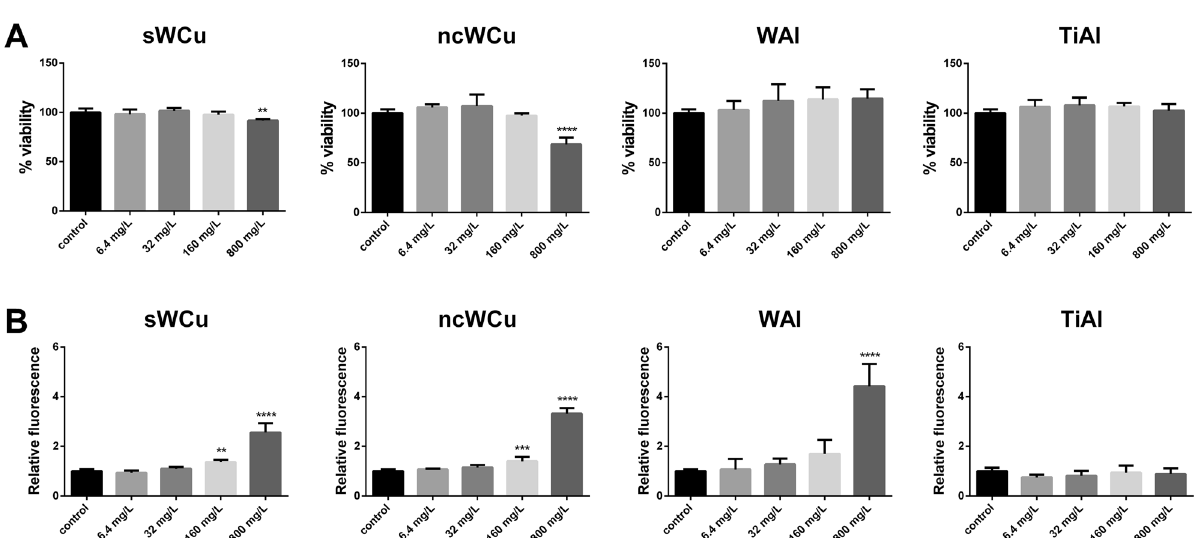
Figure 3. Effects in A549 cells after being exposed to different concentrations of the powder leachates. ( A ) Viability of A549 cells (Neutral Red assay). Results are expressed as % of control (untreated cells). ( B ) Oxidative stress (ROS levels) in A549 cells. Results are expressed as the relative fluorescence value to the control (untreated cells) which was assigned a value of 1. Data represent the mean ± standard deviation, SD. Differences were established using a One-way ANOVA followed by Dunnett post hoc test to compare every mean with the control, and considered significant at P ≤ 0.05. ** P ≤ 0.01, *** P ≤ 0.001, **** P ≤